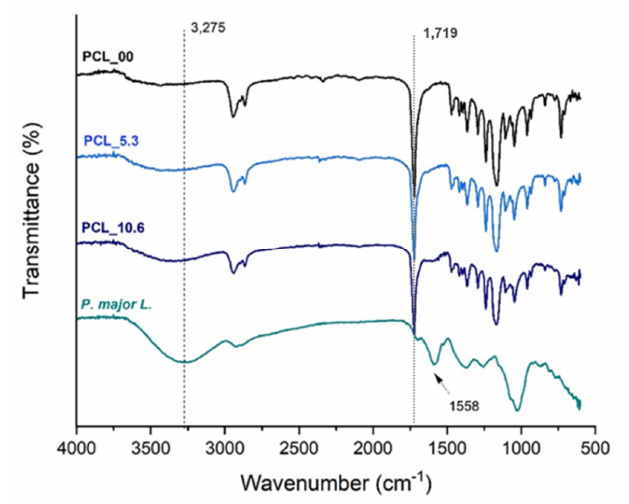
Figure 6. FTIR-ATR spectra of the PCL electrospun mats with di ff erent amounts of Plantago major extract and the freeze-dried extract.